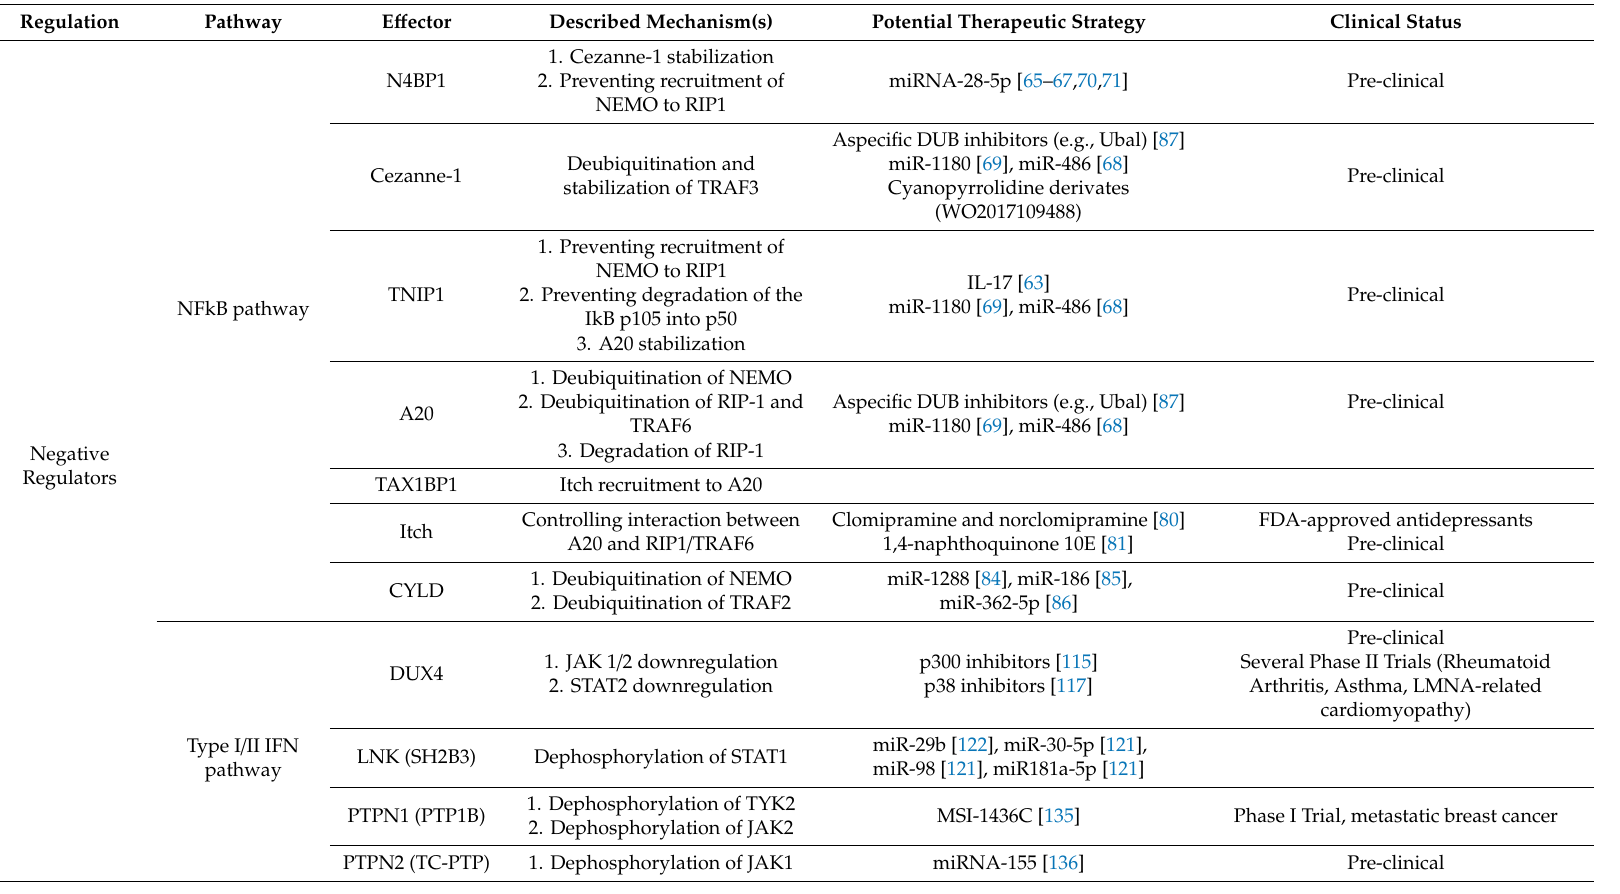
Table 1. Overview of described pathways and potential therapeutic strategies to boost MHC-I antigen